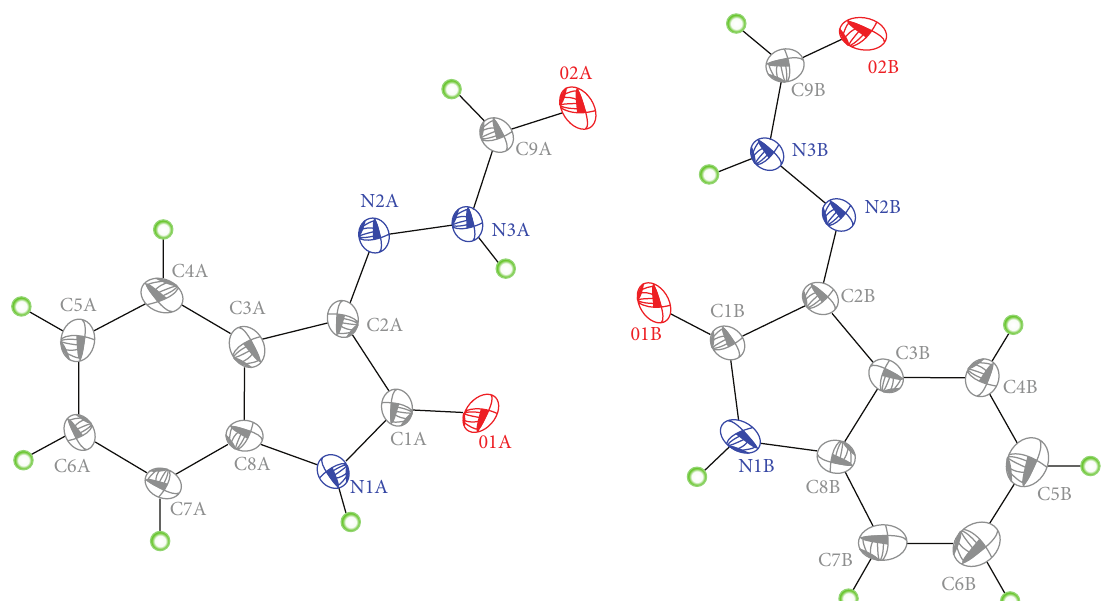
Figure 3: The asymmetric unit of compound 2 showing the atomic numbering and 40% probability displacement ellipsoids, cis : trans = 1:1.